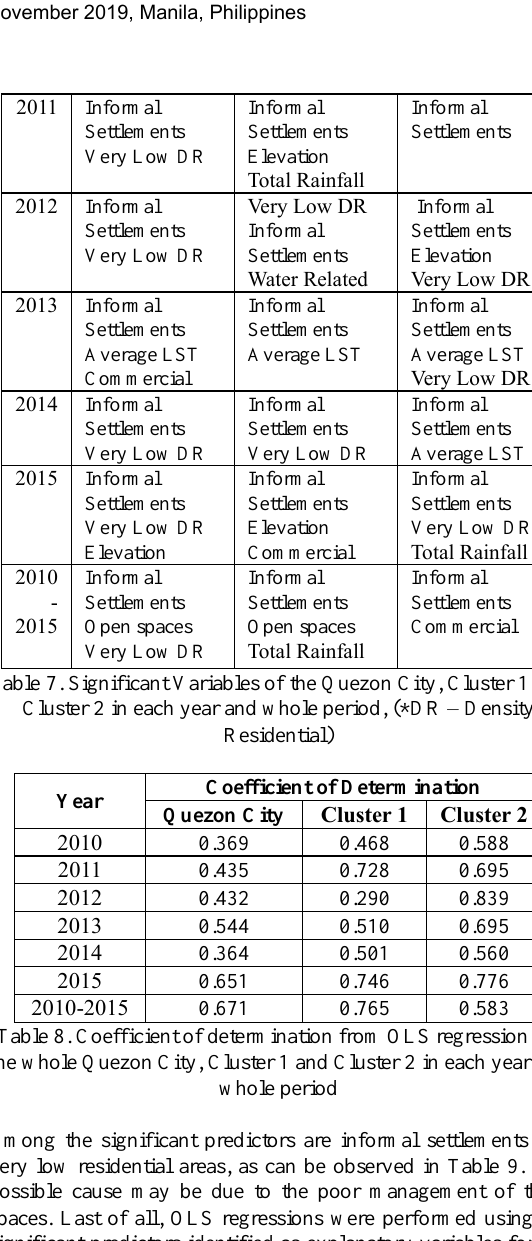
Figure 11. Time-series plot of dengue cases per cluster from the SOM 2010-2015.